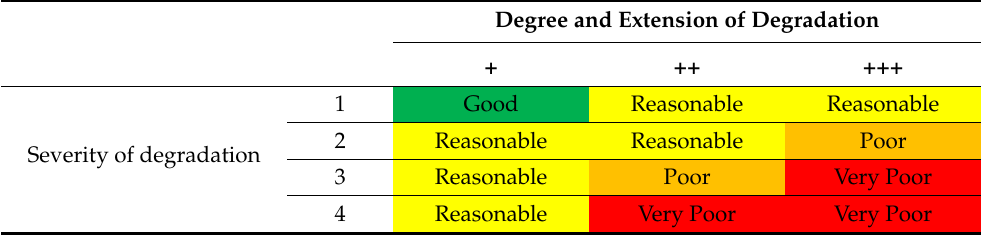
Table 4. Matrix used for state of conservation classification.